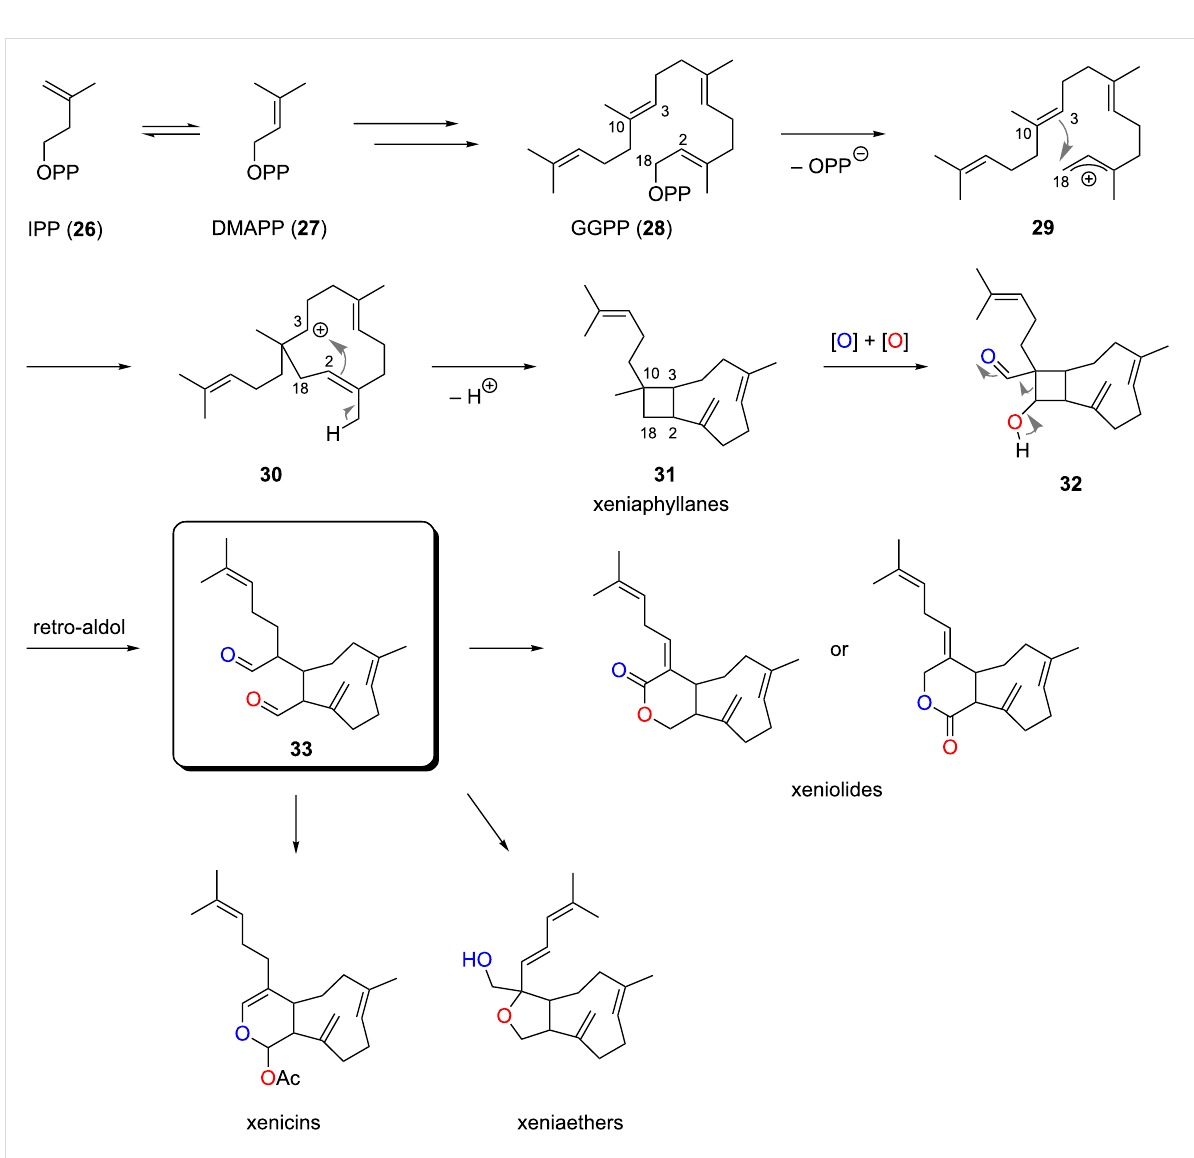
Scheme 1: Proposed biosynthesis of Xenia diterpenoids (OPP = pyrophosphate, GGPP = geranylgeranyl pyrophosphate, IPP = isoprenyl pyrophos- phate, DMAPP = dimethylallyl